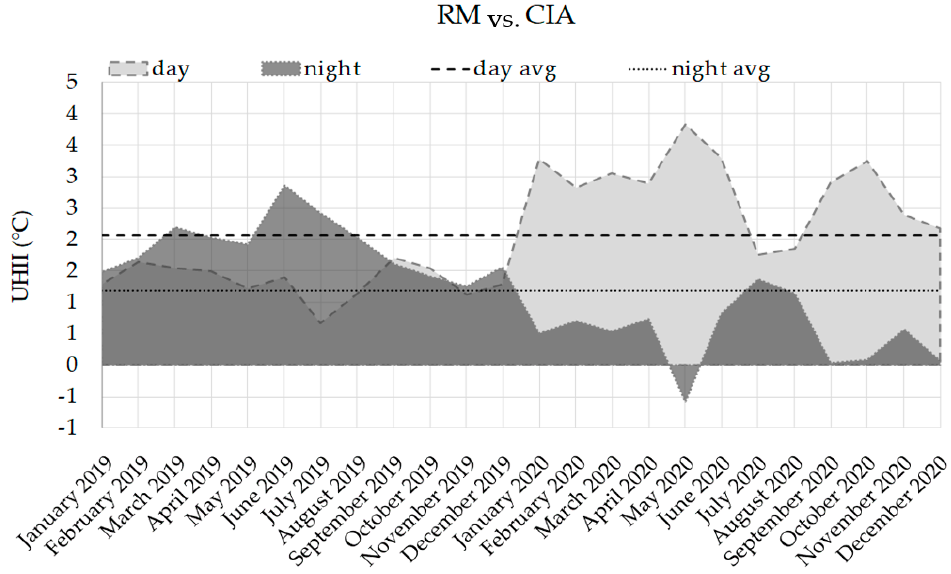
Figure 7. UHII comparison of Rome and Ciampino during the day and night.